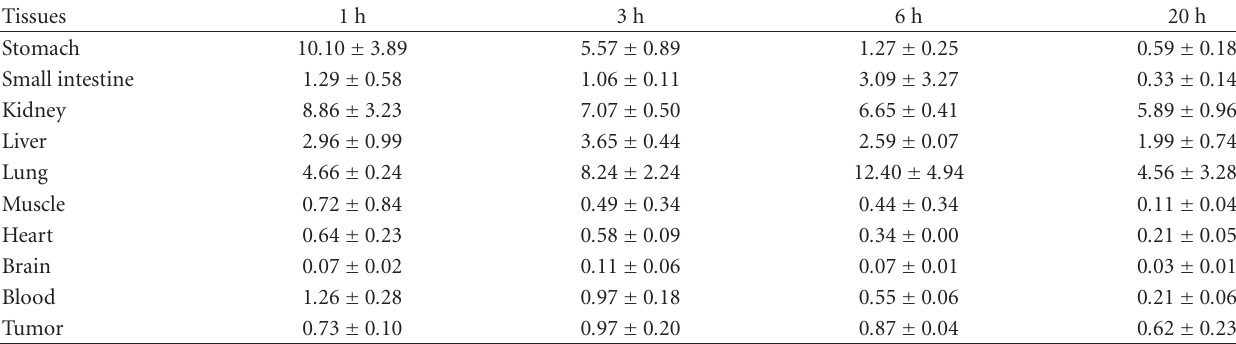
Table 2: Biodistribution of 99m Tc labeled compound 5 in nude mice bearing human colonic cancer xenografts at various time intervals (% ID/g, n = 3, x ± SD).